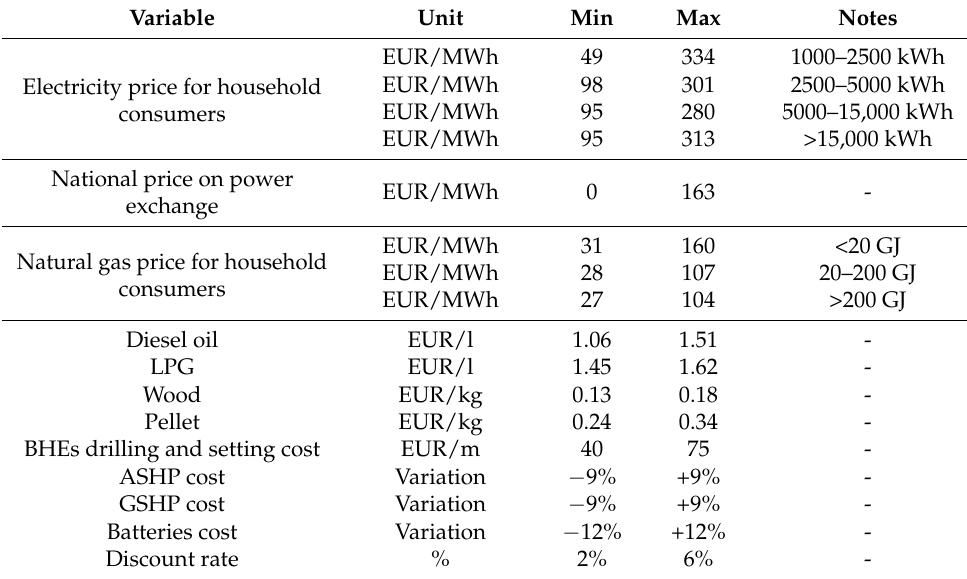
Table 8. Minimum and maximum values assumed in the sensitivity